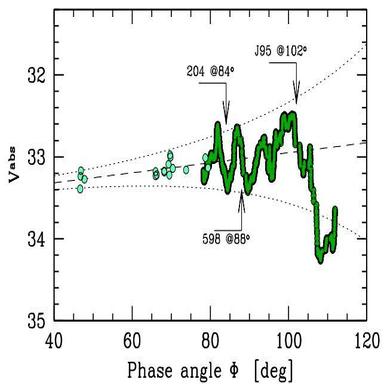
The absolute V-band magnitude trend with orbital phase angle / along the final approaching trajectory of WT1190F. The Nov 12–13 DeSS observations (green solid curve), for / > 78 are merged with the Loiano coarser set of measures, sampling lower phase-angle figures. Note the diverging oscillating regime of WT1190F luminosity on 20 min timescales, that abruptly sets in place with / approaching and exceeding a square-angle illumination aspect. To better single out the trend, DeSS data have been smoothed with a